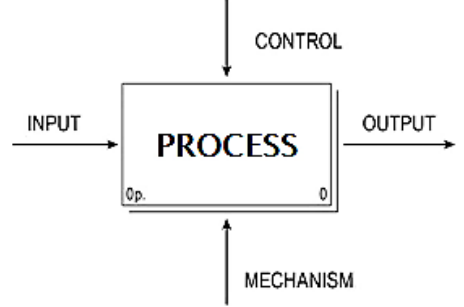
Fig. 1. Main elements of process modeling